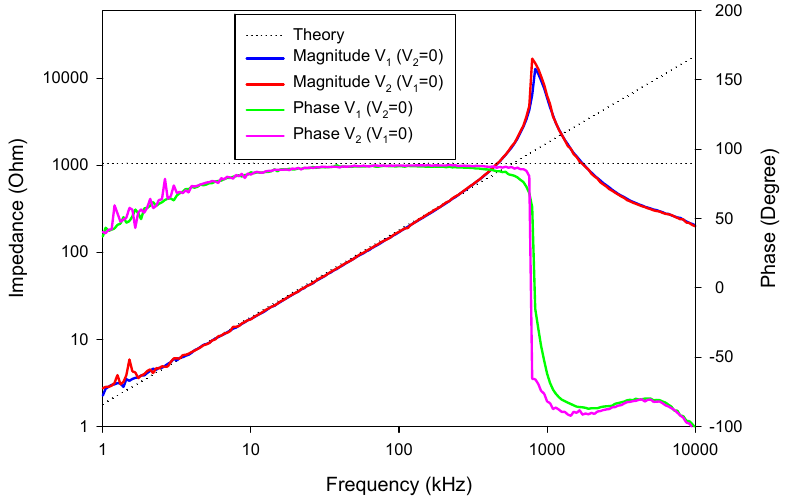
Figure 33. Experimental setup used to measure the input impedance at the first port ( v 1 ).